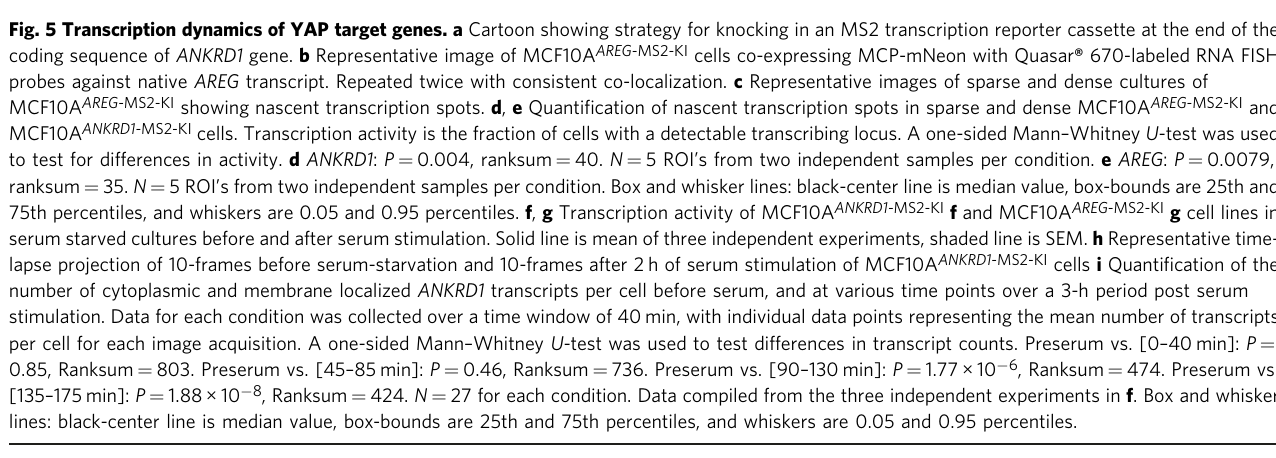
Fig. 5 Transcription dynamics of YAP target genes. a Cartoon showing strategy for knocking in an MS2 transcription reporter cassette at the end of the coding sequence of ANKRD1 gene. b Representative image of MCF10A AREG -MS2-KI cells co-expressing MCP-mNeon with Quasar ® 670-labeled RNA FISH probes against native AREG transcript. Repeated twice with consistent co-localization. c Representative images of sparse and dense cultures of MCF10A AREG -MS2-KI showing nascent transcription spots. d , e Quanti fi cation of nascent transcription spots in sparse and dense MCF10A AREG -MS2-KI and MCF10A ANKRD1 -MS2-KI cells. Transcription activity is the fraction of cells with a detectable transcribing locus. A one-sided Mann – Whitney U -test was used to test for differences in activity. d ANKRD1 : P = 0.004, ranksum = 40. N = 5 ROI ’ s from two independent samples per condition. e AREG : P = 0.0079, ranksum = 35. N = 5 ROI ’ s from two independent samples per condition. Box and whisker lines: black-center line is median value, box-bounds are 25th and 75th percentiles, and whiskers are 0.05 and 0.95 percentiles. f , g Transcription activity of MCF10A ANKRD1 -MS2-KI f and MCF10A AREG -MS2-KI g cell lines in serum starved cultures before and after serum stimulation. Solid line is mean of three independent experiments, shaded line is SEM. h Representative time- lapse projection of 10-frames before serum-starvation and 10-frames after 2 h of serum stimulation of MCF10A ANKRD1 -MS2-KI cells i Quanti fi cation of the number of cytoplasmic and membrane localized ANKRD1 transcripts per cell before serum, and at various time points over a 3-h period post serum stimulation. Data for each condition was collected over a time window of 40 min, with individual data points representing the mean number of transcripts per cell for each image acquisition. A one-sided Mann – Whitney U -test was used to test differences in transcript counts. Preserum vs. [0 – 40 min]: P = 0.85, Ranksum = 803. Preserum vs. [45 – 85 min]: P = 0.46, Ranksum = 736. Preserum vs. [90 – 130 min]: P = 1.77 × 10 − 6 , Ranksum = 474. Preserum vs. [135 – 175 min]: P = 1.88 × 10 − 8 , Ranksum = 424. N = 27 for each condition. Data compiled from the three independent experiments in f . Box and whisker lines: black-center line is median value, box-bounds are 25th and 75th percentiles, and whiskers are 0.05 and